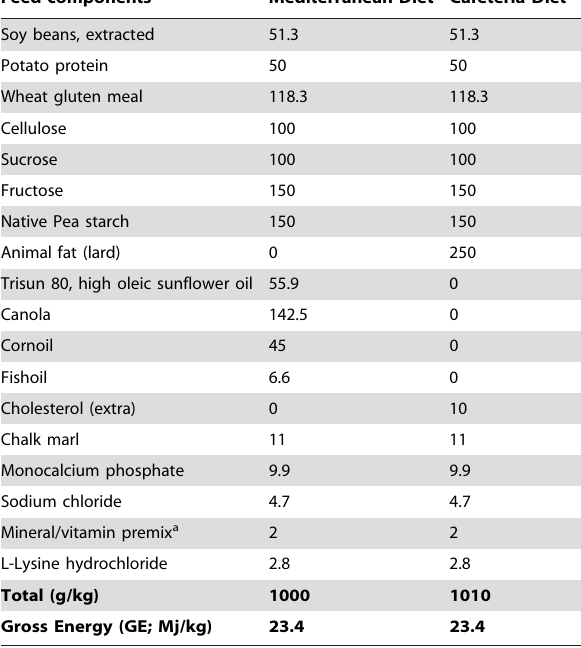
Table 1. Composition of the high unsaturated fat (Mediterranean) diet and the high saturated fat (cafeteria)